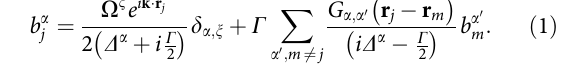
shift significantly exceeds the predicted value based on general S -matrix calculations of s -wave collisions 52 (2.18 (cid:3) 10 (cid:2) 10 Hz cm 3 if the unitary limit is used).